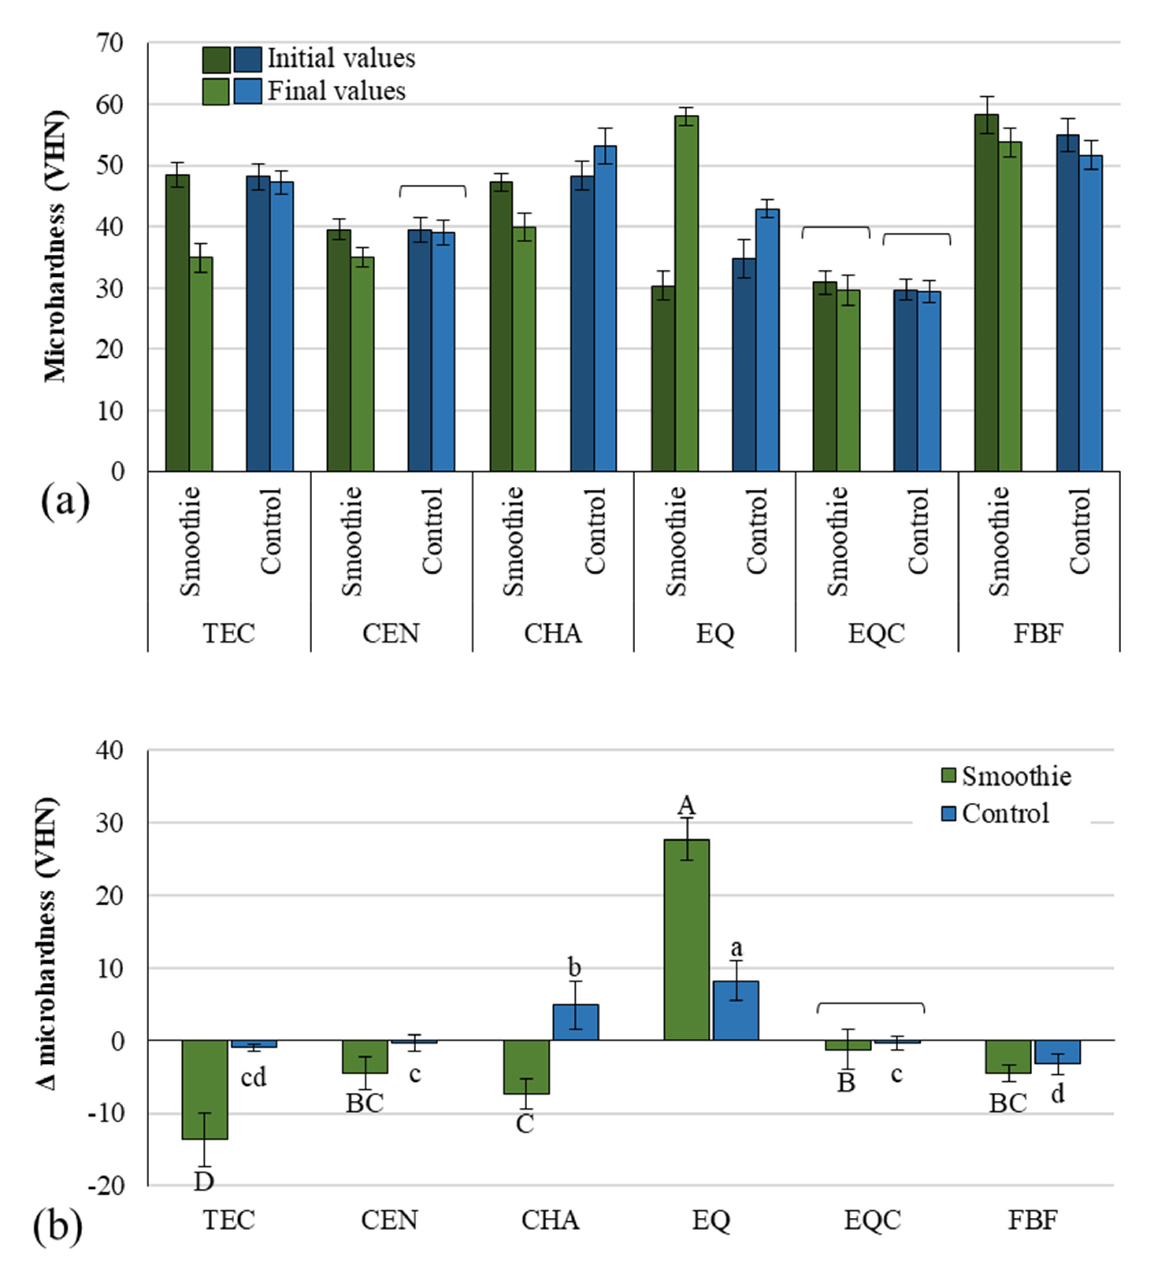
Figure 2. Microhardness (mean values ± 1 standard deviation, n = 10) measured 24 h after specimen preparation and after 1 month of immersion ( a ), and delta microhardness (mean values ± s.d.) representing microhardness change between these two time points ( b ). Square brackets indicate statistically similar values. Same uppercase letters indicate statistically similar values within the smoothie group. Same lowercase letters indicate statistically similar values within the control group. TEC: Tetric EvoCeram, CEN: Cention, CHA: Charisma Classic, EQ: Equia Forte HT Fil Uncoated, EQC: Equia Forte HT Fil Coated FBF: Filtek Bulk Fill.